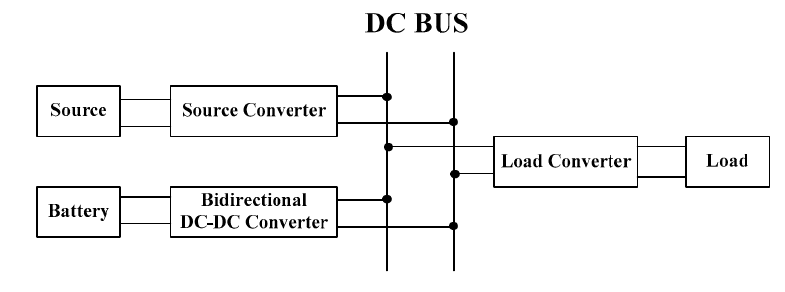
Figure 1. The generic DC microgrid (DC-MG).